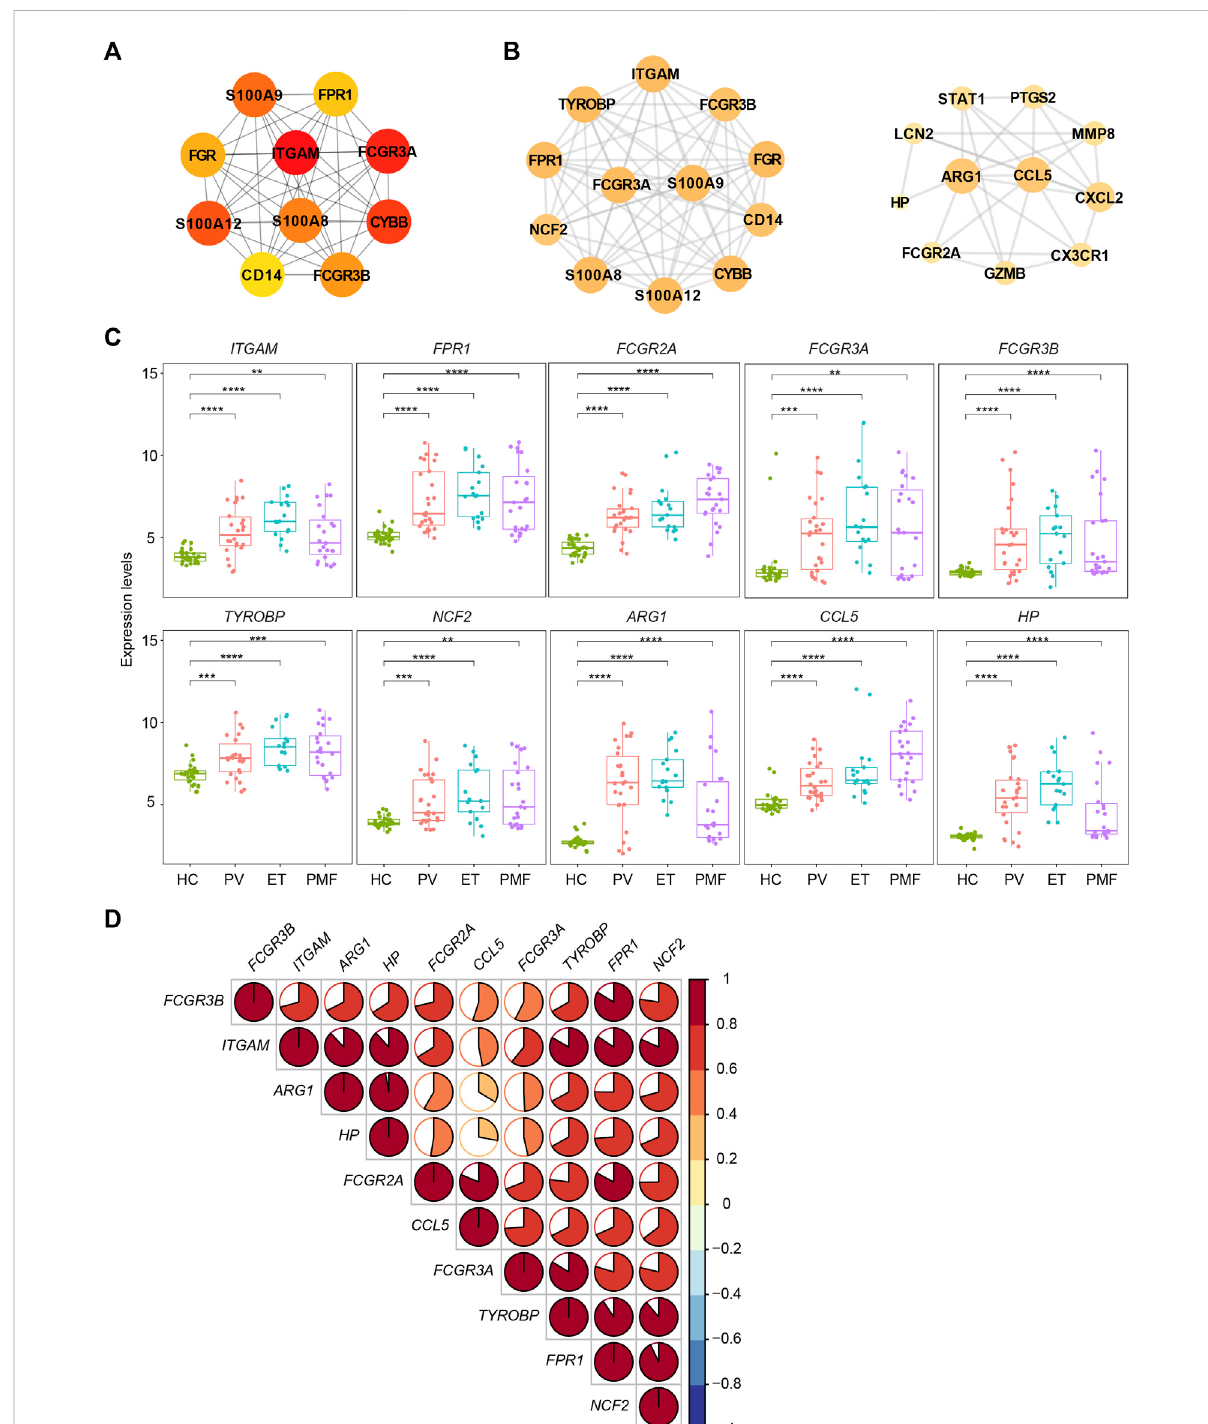
FIGURE 4 (A) Top 10 hub genes from the PPI network analysis for the overlapping upregulated genes in three MPN subtypes. Nodes denote encoded proteins, and edges denote the interaction between encoded proteins. The color represents the scores ranked by the MCC method. The deeper color denotes the more important genes having higher scores. (B) Top two signi fi cant modules from the PPI network analysis for the overlapping upregulated genes in three MPN subtypes. The color and size represent the degrees of the nodes. The bigger size and deeper color denote the more important genes having higher degrees. (C) Expression levels of the in fl ammation- and immune-related genes upregulated in three MPN subtypes. (D) Correlation of the expression levels of the upregulated genes in (C)